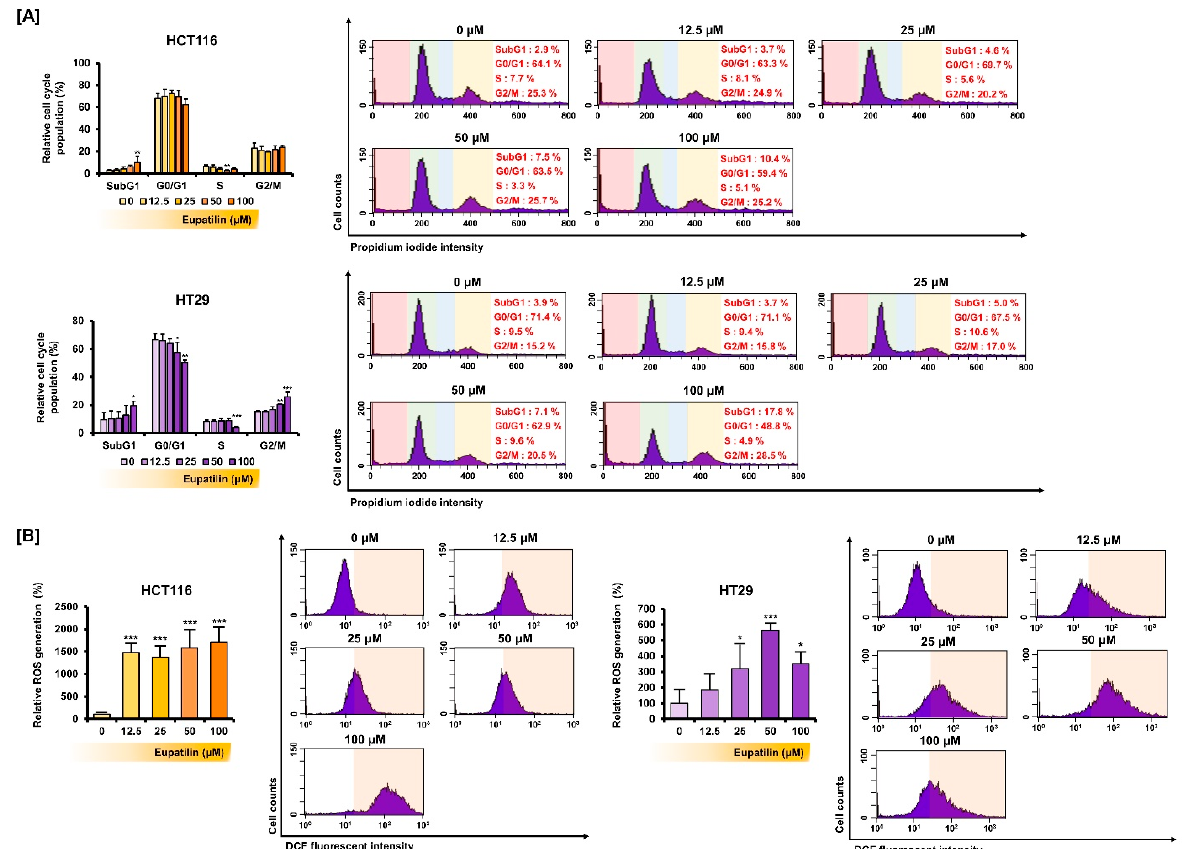
Figure 3. Effect of eupatilin on cell cycle and ROS production in colon cancer cells. ( A ) Cell cycle distribution was confirmed by PI staining. ( B ) Eupatilin-induced intracellular ROS production estimated by flowcytometric detection. The number of DCF green fluorescence-labeled cells represents the relative quantities of intracellular hydrogen peroxide in eupatilin-treated cells. Asterisks indicate a significant change after eupatilin treatment (*** p < 0.001, ** p < 0.01, and * p < 0.05).